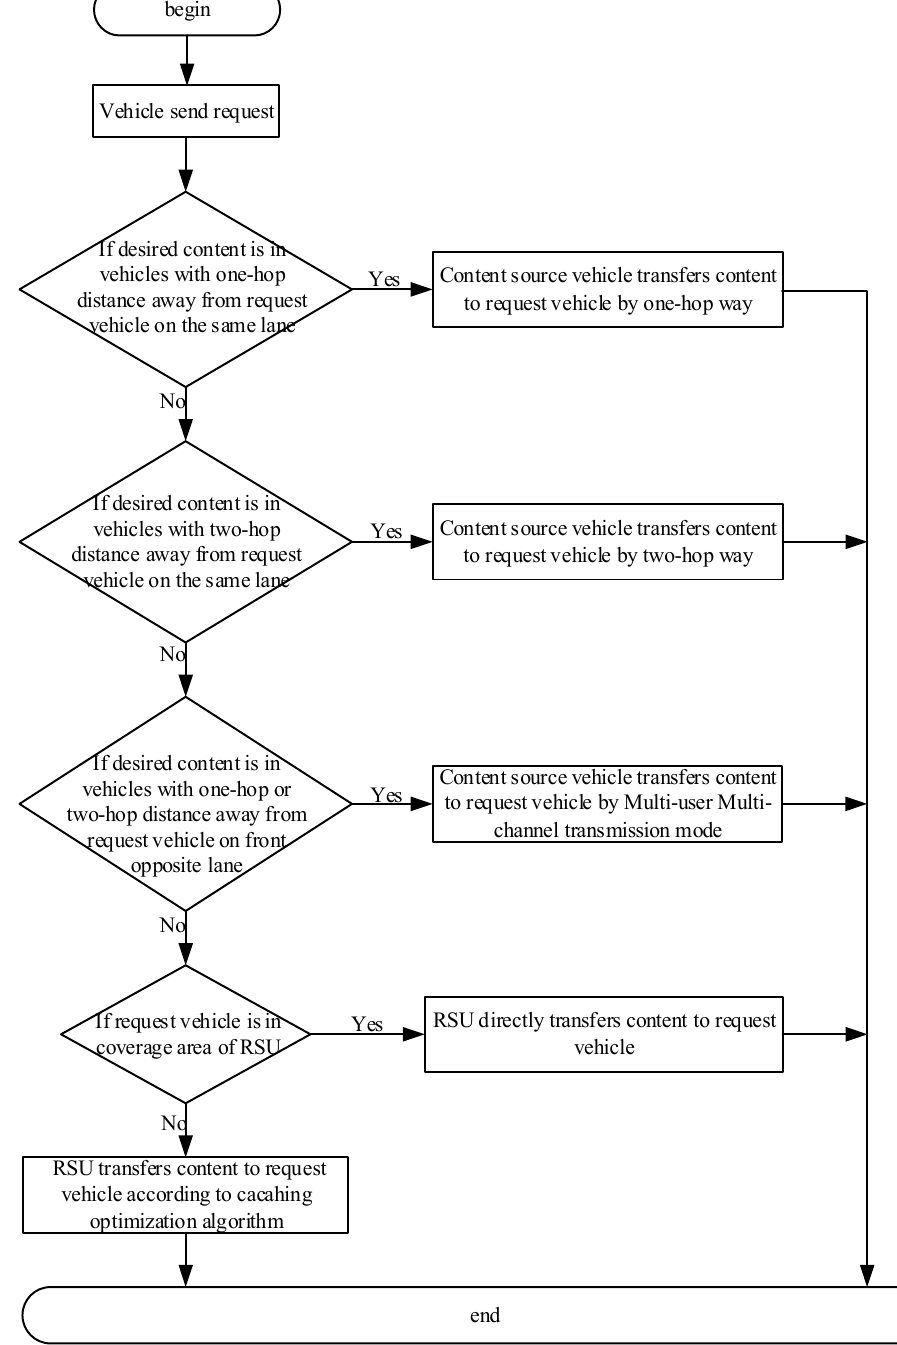
Figure 2. The flowchart of content